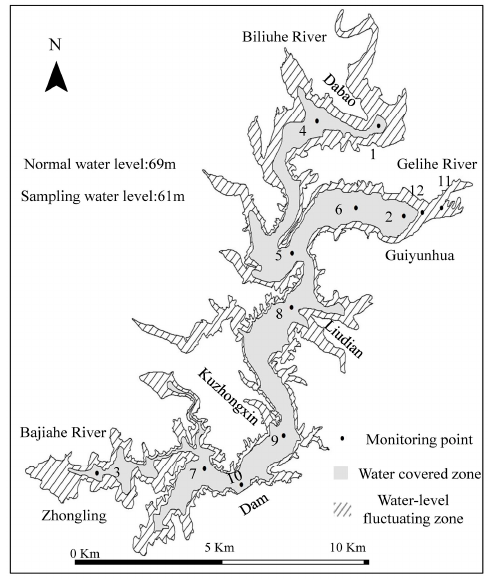
Figure 1. The distribution map of monitoring points of Biliuhe reservoir.